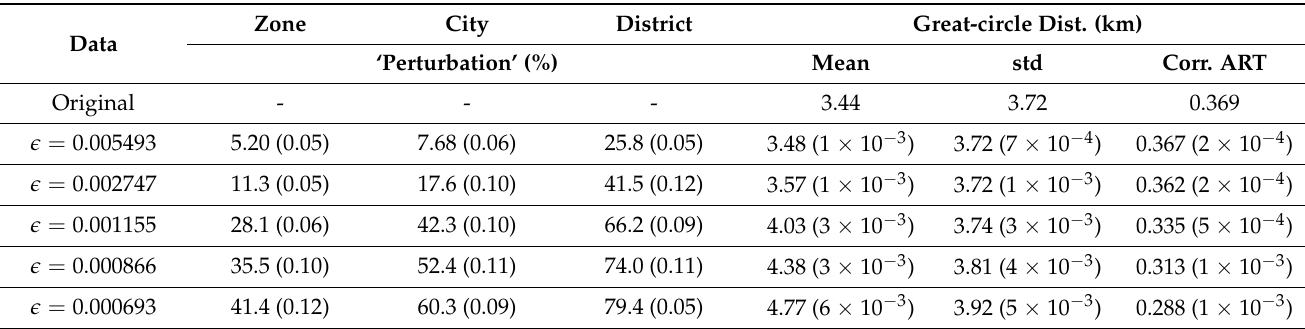
Table 3. Percentage of perturbation for categorical attributes (city, zone, and district) according to (cid:101) and statistical properties (mean and std values and correlation with ART) of the original and GI-based datasets for the great-circle distance attribute. Mean(std) values are reported since we repeated our experiments with 10 different seeds. Zone City District Great-circle Dist. (km) Data